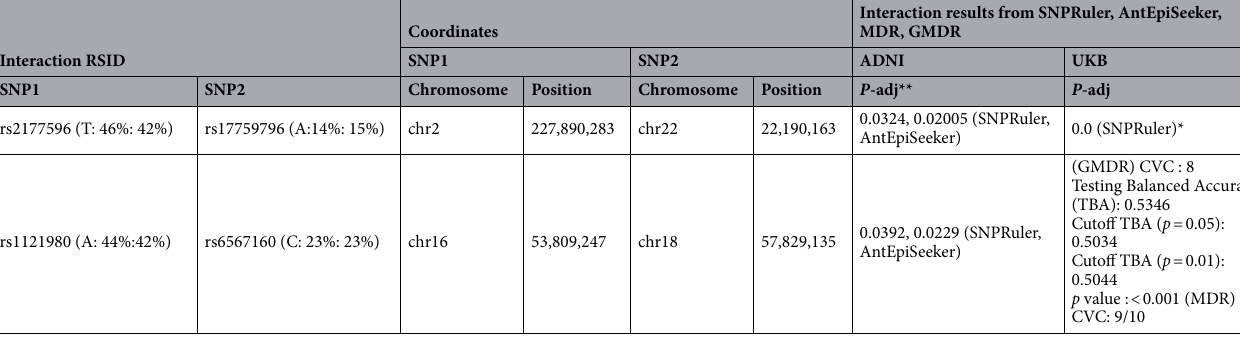
Table 1. Significant epistatic pairwise SNP interactions for BMI associated loci. Chromosome and position with respect to GRCh37. * P < 10 −16 . (Effect allele: Frequency in ADNI: Frequency in UKB). ** P -adj is based on 1000 permutation